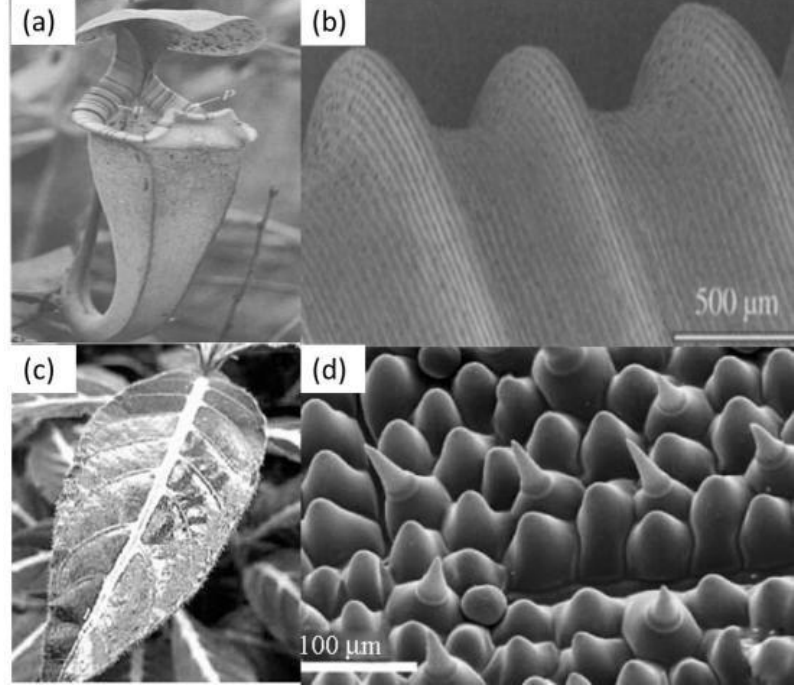
Figure 5. ( a ) Pitcher plant and ( b ) its microstructure [115]; reproduced with permission from The Royal Society. ( c ) Ruelliadevosiana leaf wetted by water with a contact angle of 0° and ( d ) its microstructure taken by SEM [114]; reproduced with permission from the American Chemical Society.